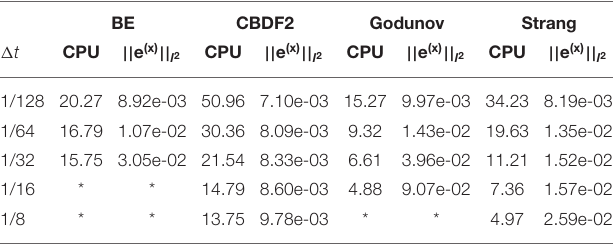
TABLE 2 | The comparison of CPU times (minutes) and the error of membrane voltage of the four methods. BE CBDF2 Godunov